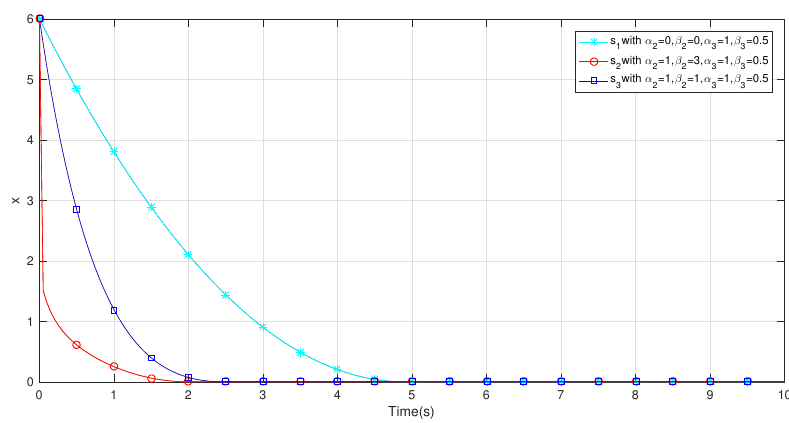
Figure 3. The comparison of different fast terminal sliding modes